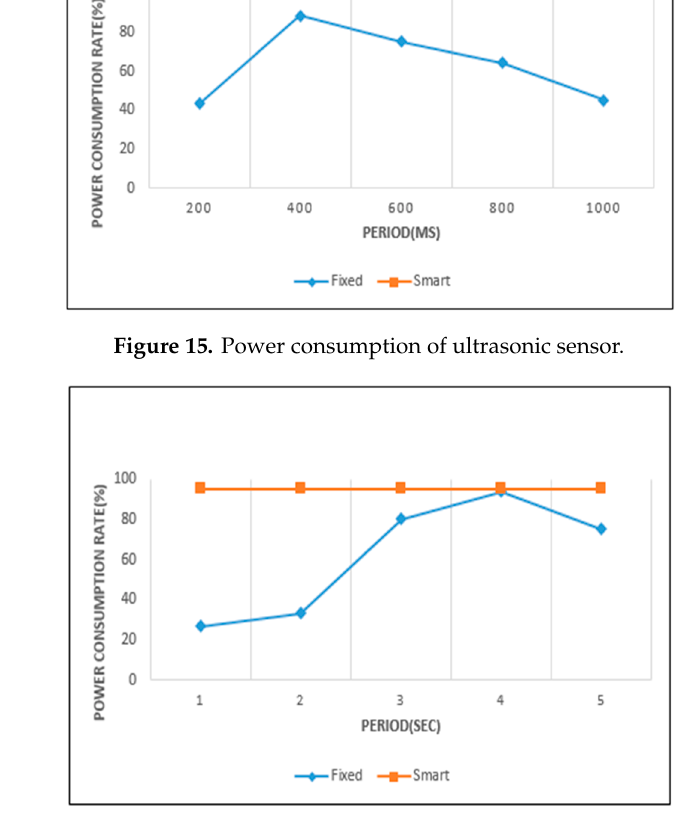
Figure 17. Power consumption error of ultrasonic sensor.